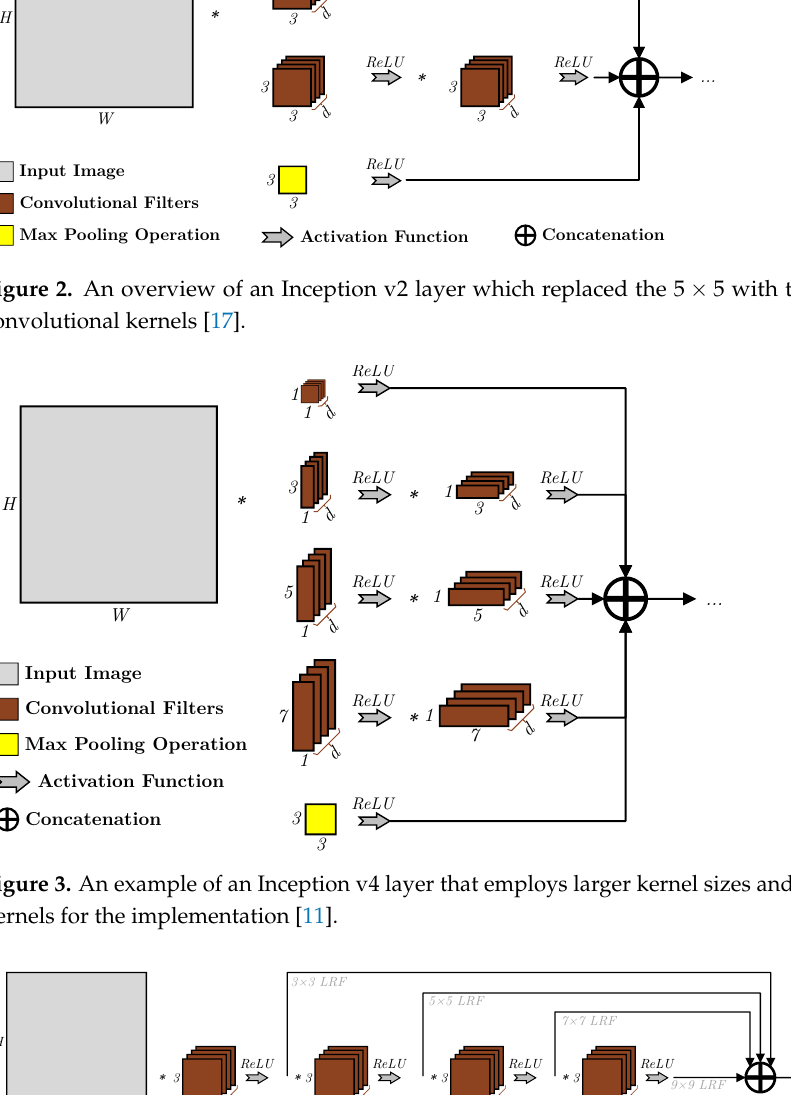
Figure 4. An example of an Inception-like layer that uses deep convolution and residual connections to emulate the behavior of an Inception layer in utilizing multiple LRFs at the output.